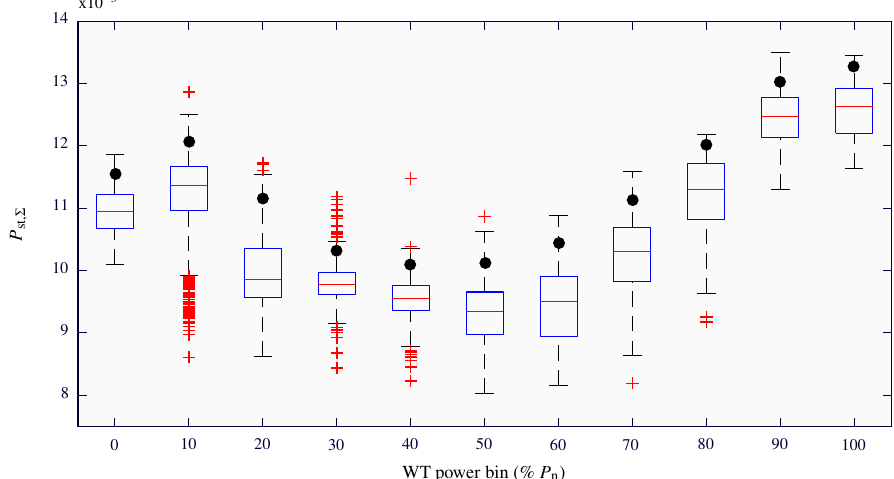
Figure 6. For a ψ k value of 87.34 ◦ , boxplots of the estimated P st, Σ values at the PCC with respect to the 15 16 power bin of the WT (2